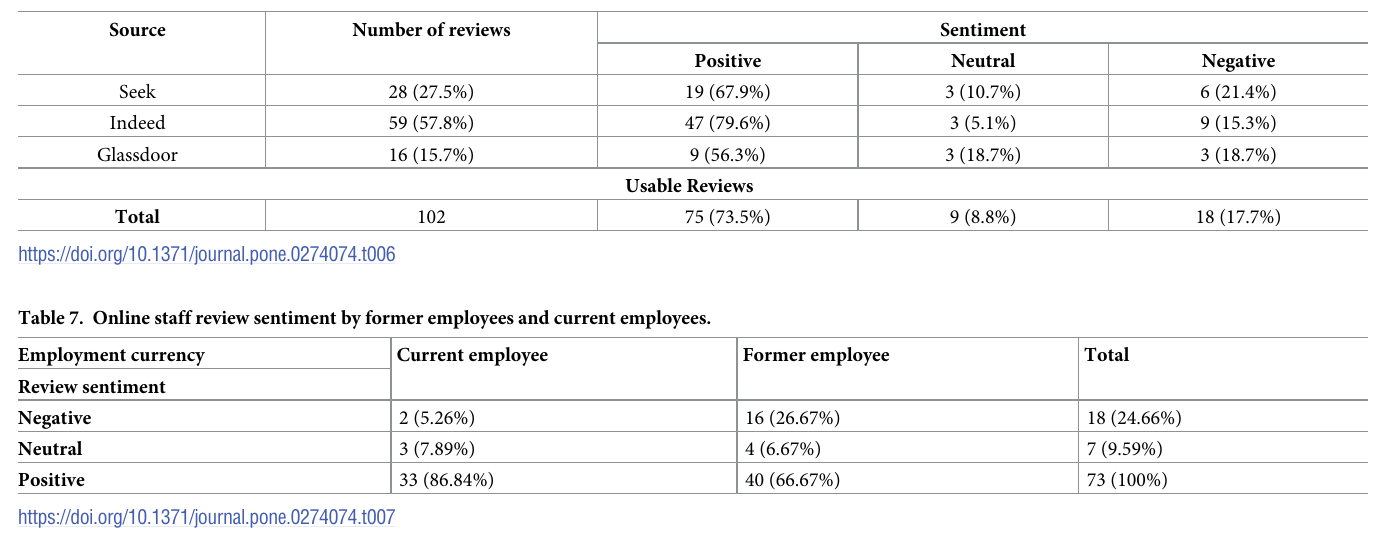
Table 6. Sentiment distributions of reviews across sites.